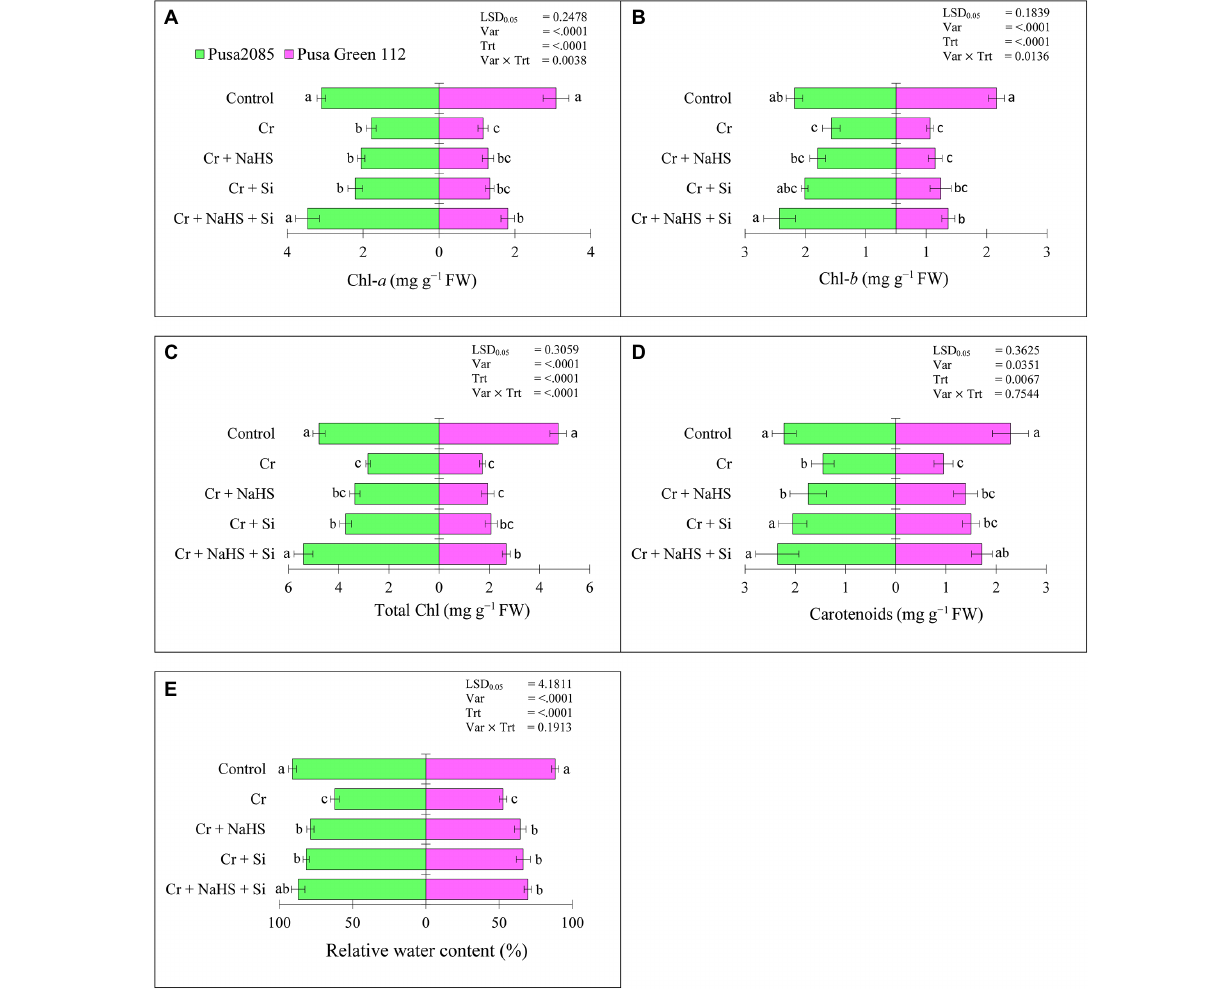
FIGURE 2 | Effect of NaHS, Si, and NaHS + Si treatments on (A) chlorophyll- a , (B) chlorophyll- b , (C) total chlorophyll, (D) carotenoids, and (E) relative water contents in leaves of both chickpea plants grown during Cr VI stress. Data are presented as mean ± SE ( n = 5) and different bar letters are indicated statistically differences ( p < 0.05) as tested by the least significant difference